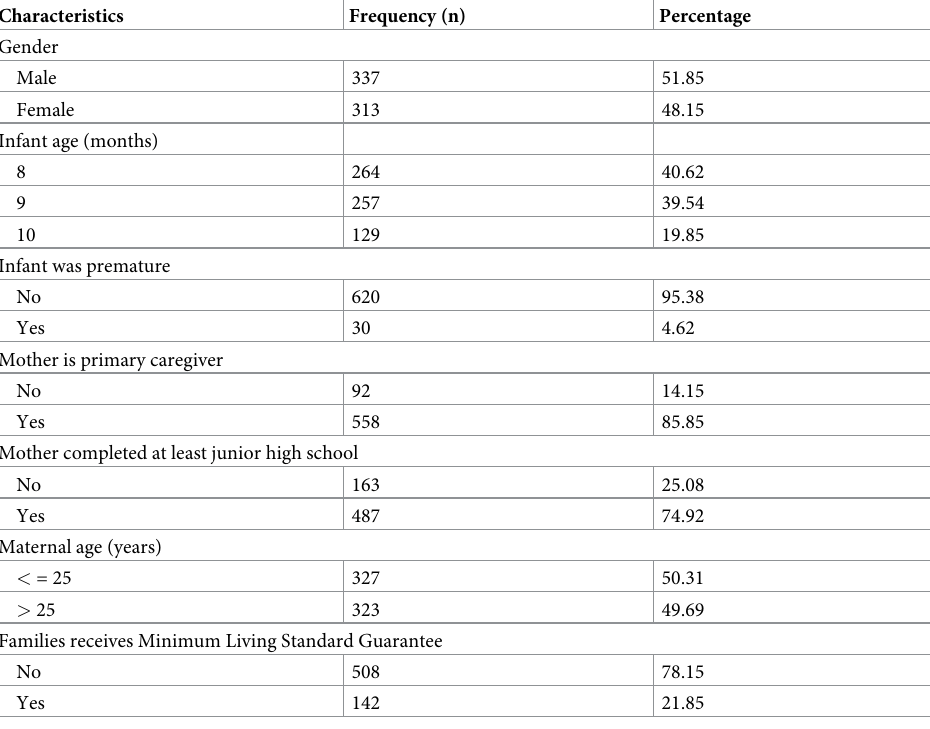
Table 1. Basic characteristics of sample infants (N = 650).